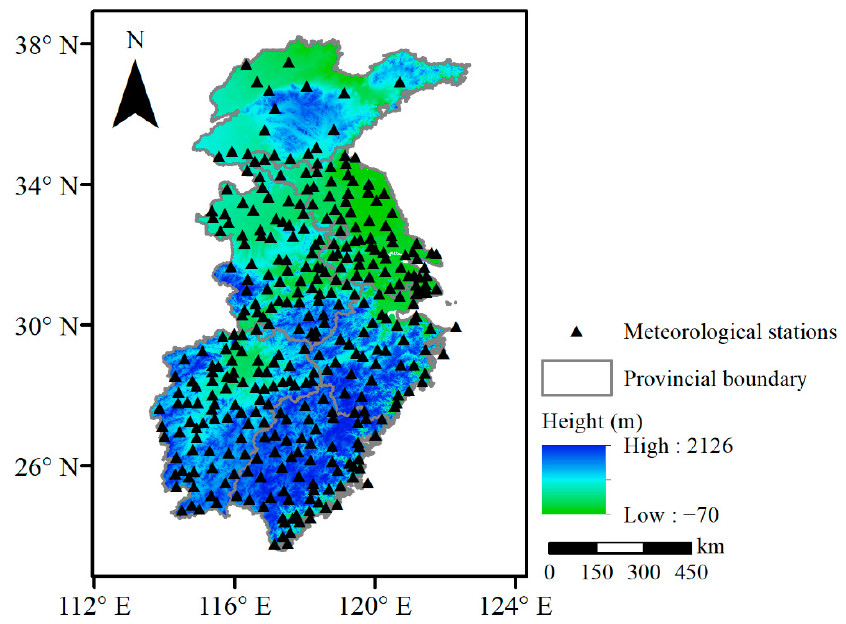
Figure 2. Distribution of the selected meteorological stations in East China.